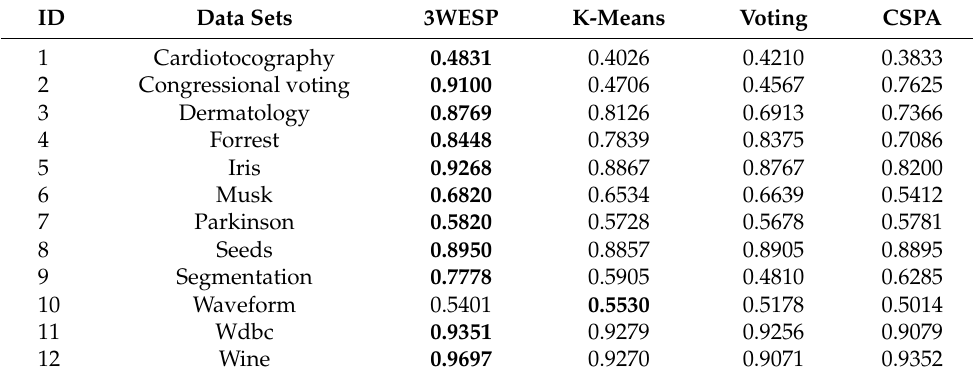
Table 5. Experimental results of ACC on UCI data